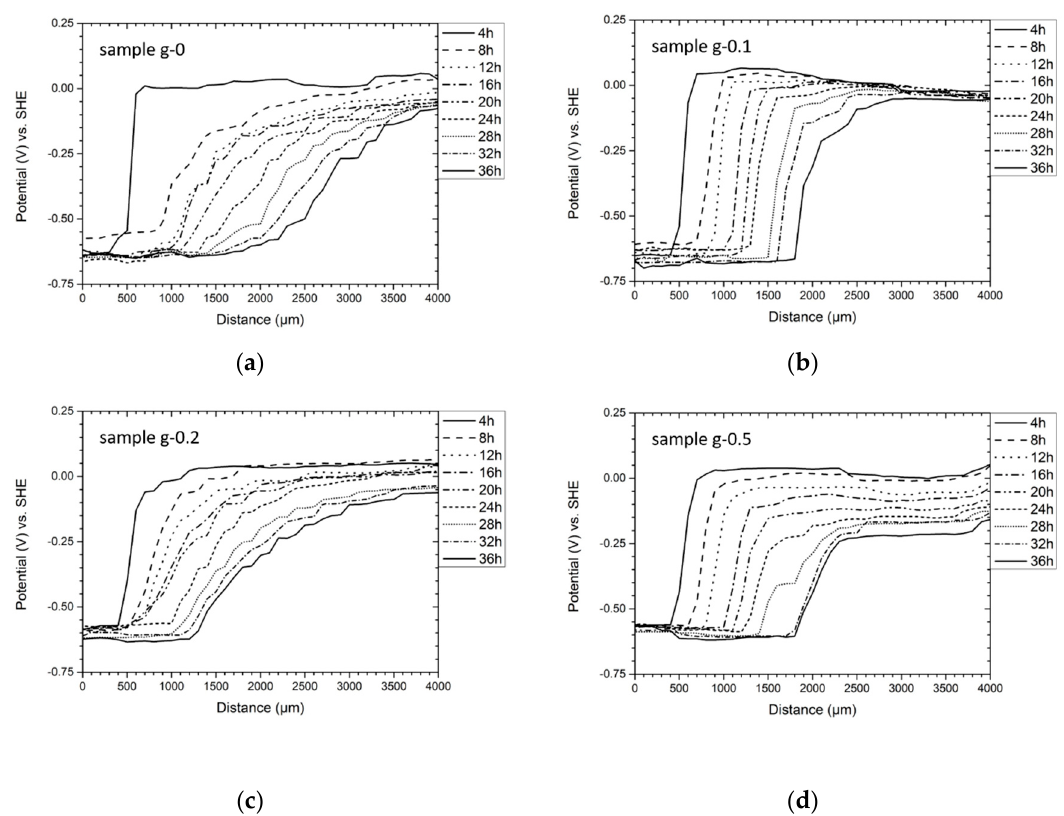
Figure 6. Scanning Kelvin probe (SKP) potential profiles of acrylic coated carbon steel sample with different amounts of fGO flakes measured with 3.5 wt.% NaCl solution as a function of time. SHE, standard hydrogen electrode. ( a ) sample g-0; ( b ) sample g-0.1; ( c ) sample g-0.2; ( d ) sample g-0.5.